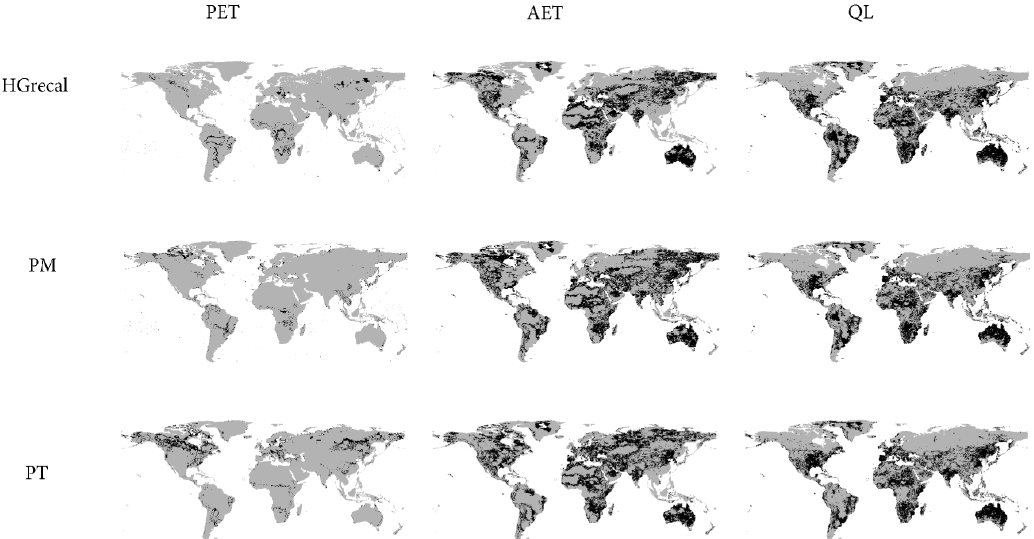
Fig. 8b. Maps showing areas where CFSR derived PET, AET and local runoff (QL) significantly deviates according to the Welch’s t-test for a significance level of 95% from CRU derived values (in grey) and areas where annual average values do not significantly deviate (in black) for the HGrecal, PM and PT equations.